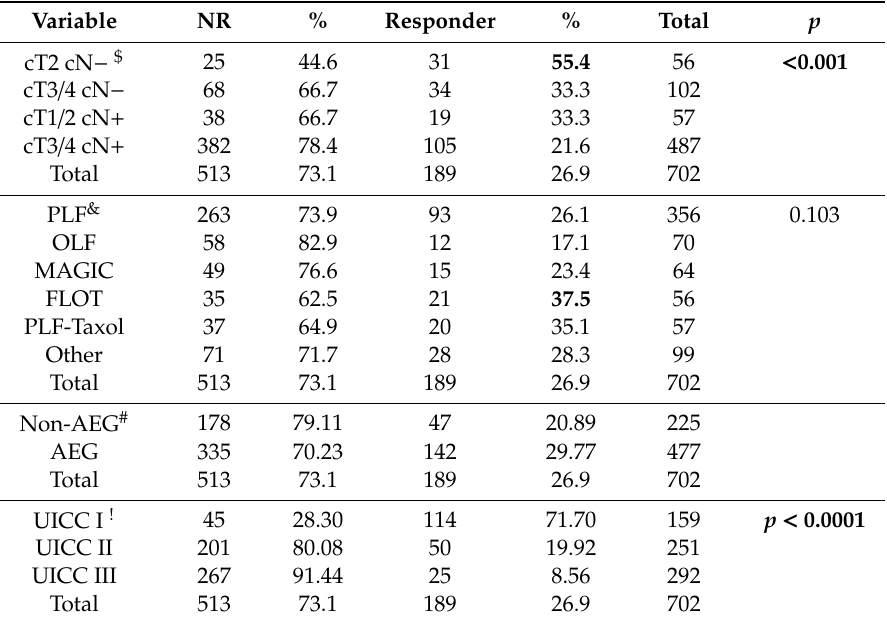
Table 4. HPR rates according to the clinical